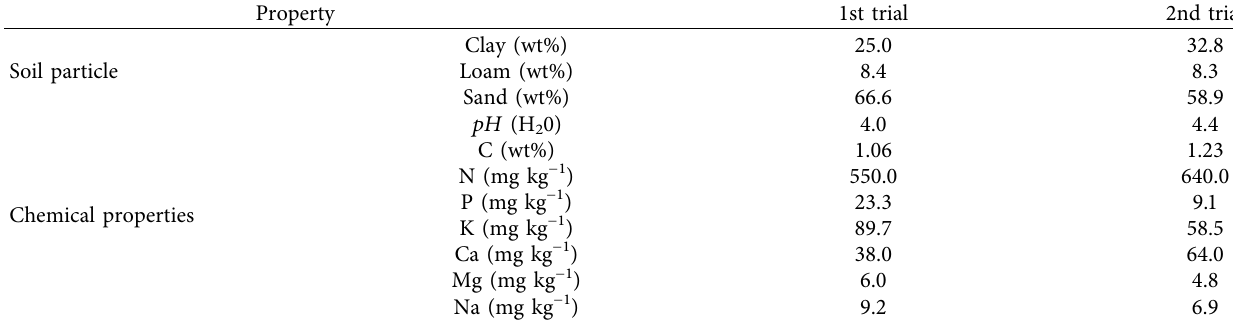
Table 1: Characteristics of the soil in the experiment.